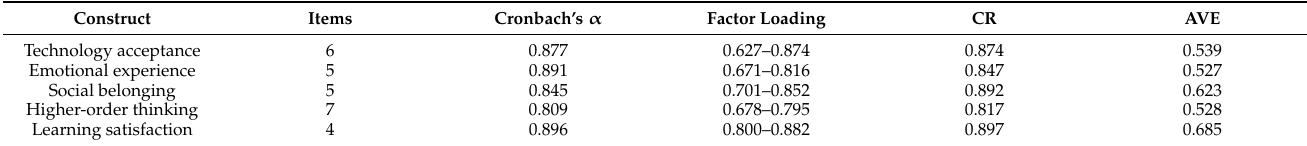
Table 1. Reliability and convergent validity